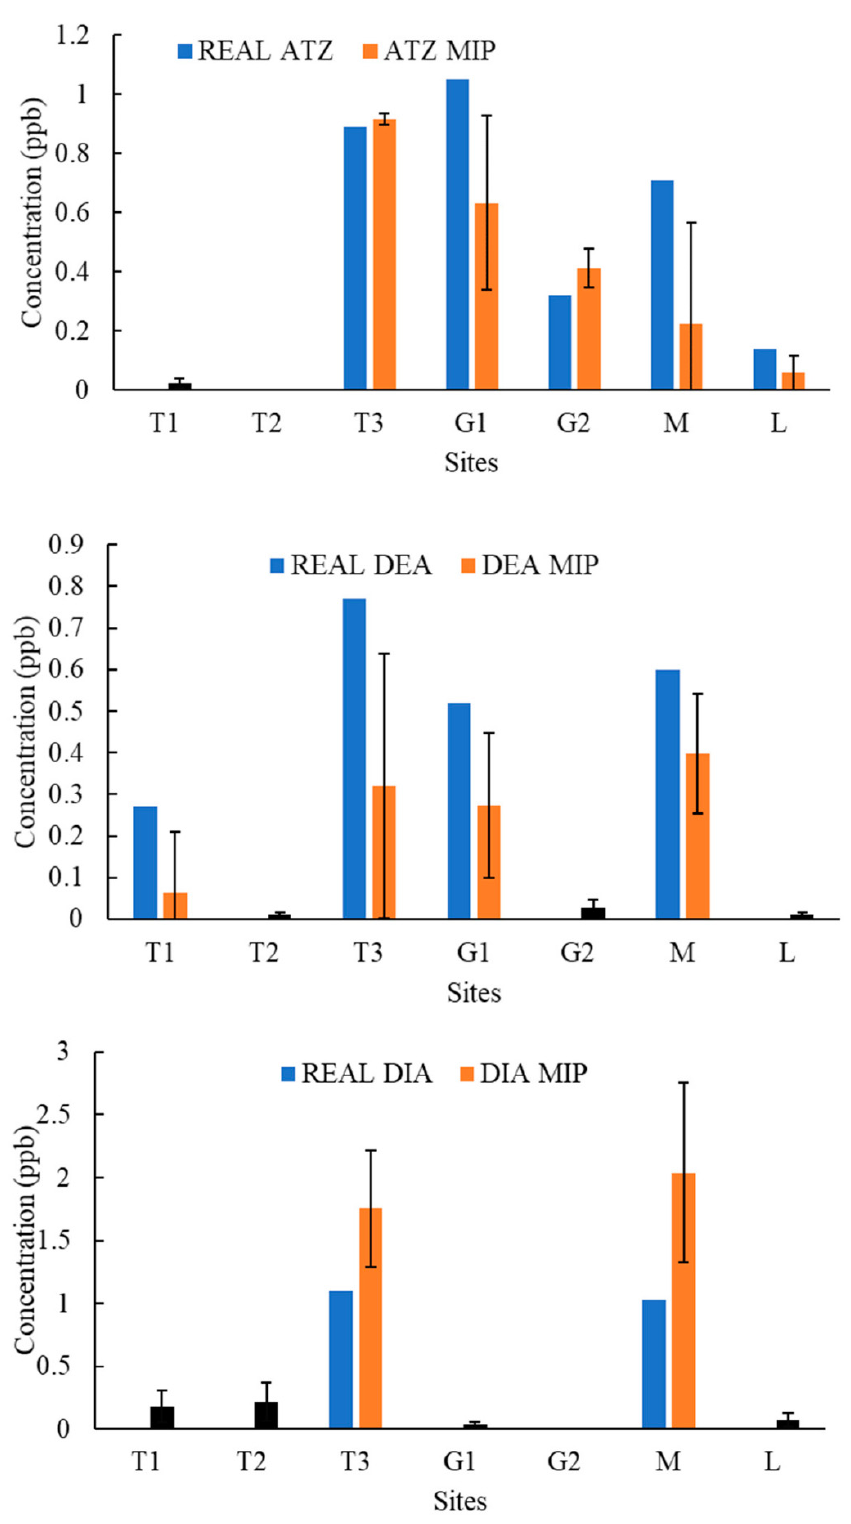
Figure 5. Average response of MIPs to ATZ, DEA, and DIA compared to real concentrations validated by LCMS/MS for samples of 19 March 2020.